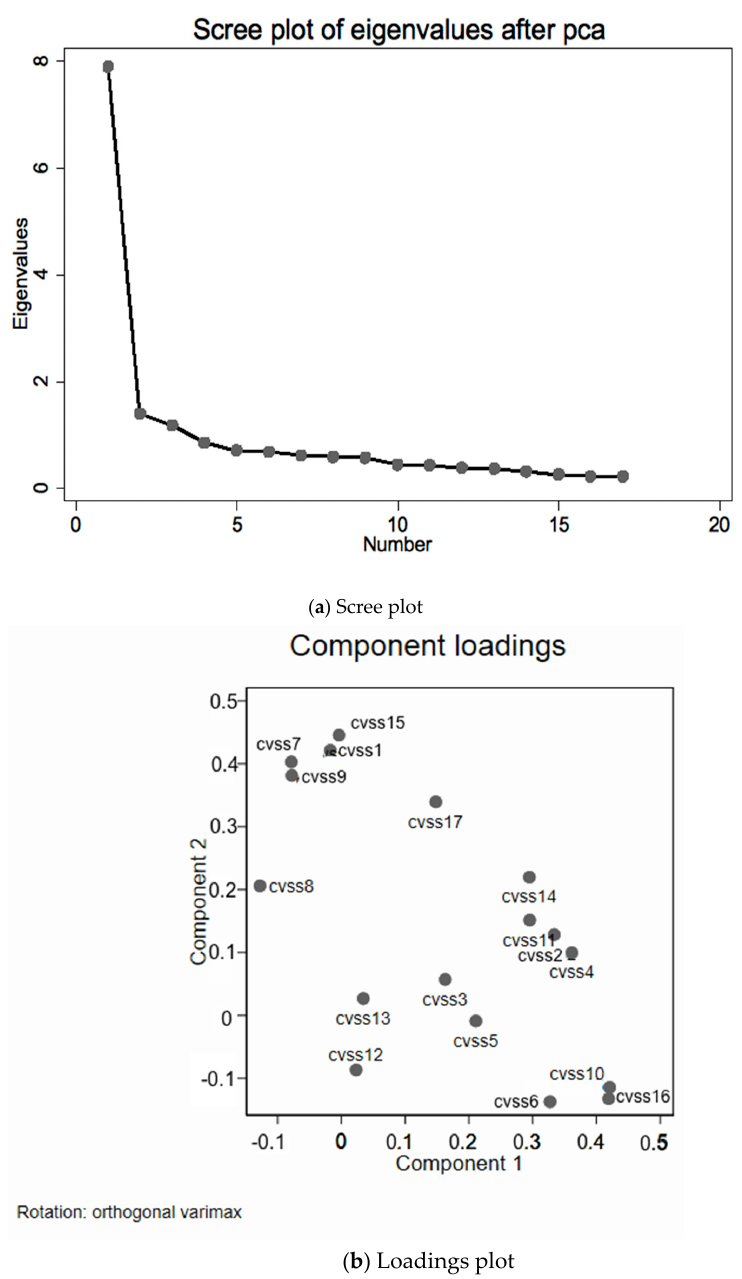
Figure 2. Principal components analysis of the Italian CVSS: scree plot and loadings plot